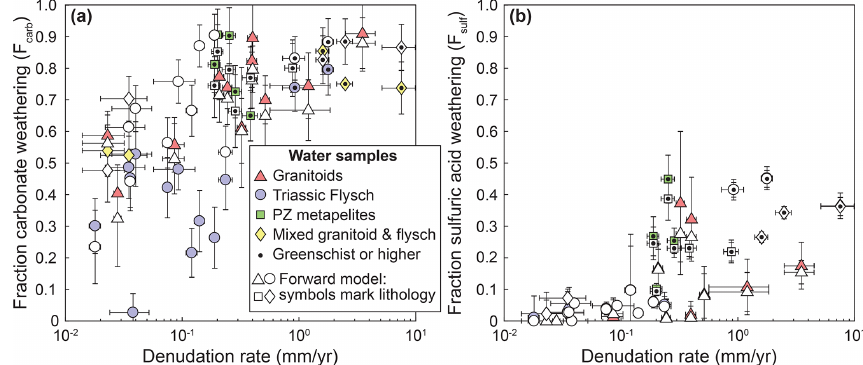
Figure A5. Forward model results for the fraction of carbonate weathering and weathering by sulfuric acid. Data from Fig. 6 are plotted with results from the forward model (white points). Lithology in the data from the forward model is distinguished by symbology only. Where results from forward and inverse approaches are similar, symbols